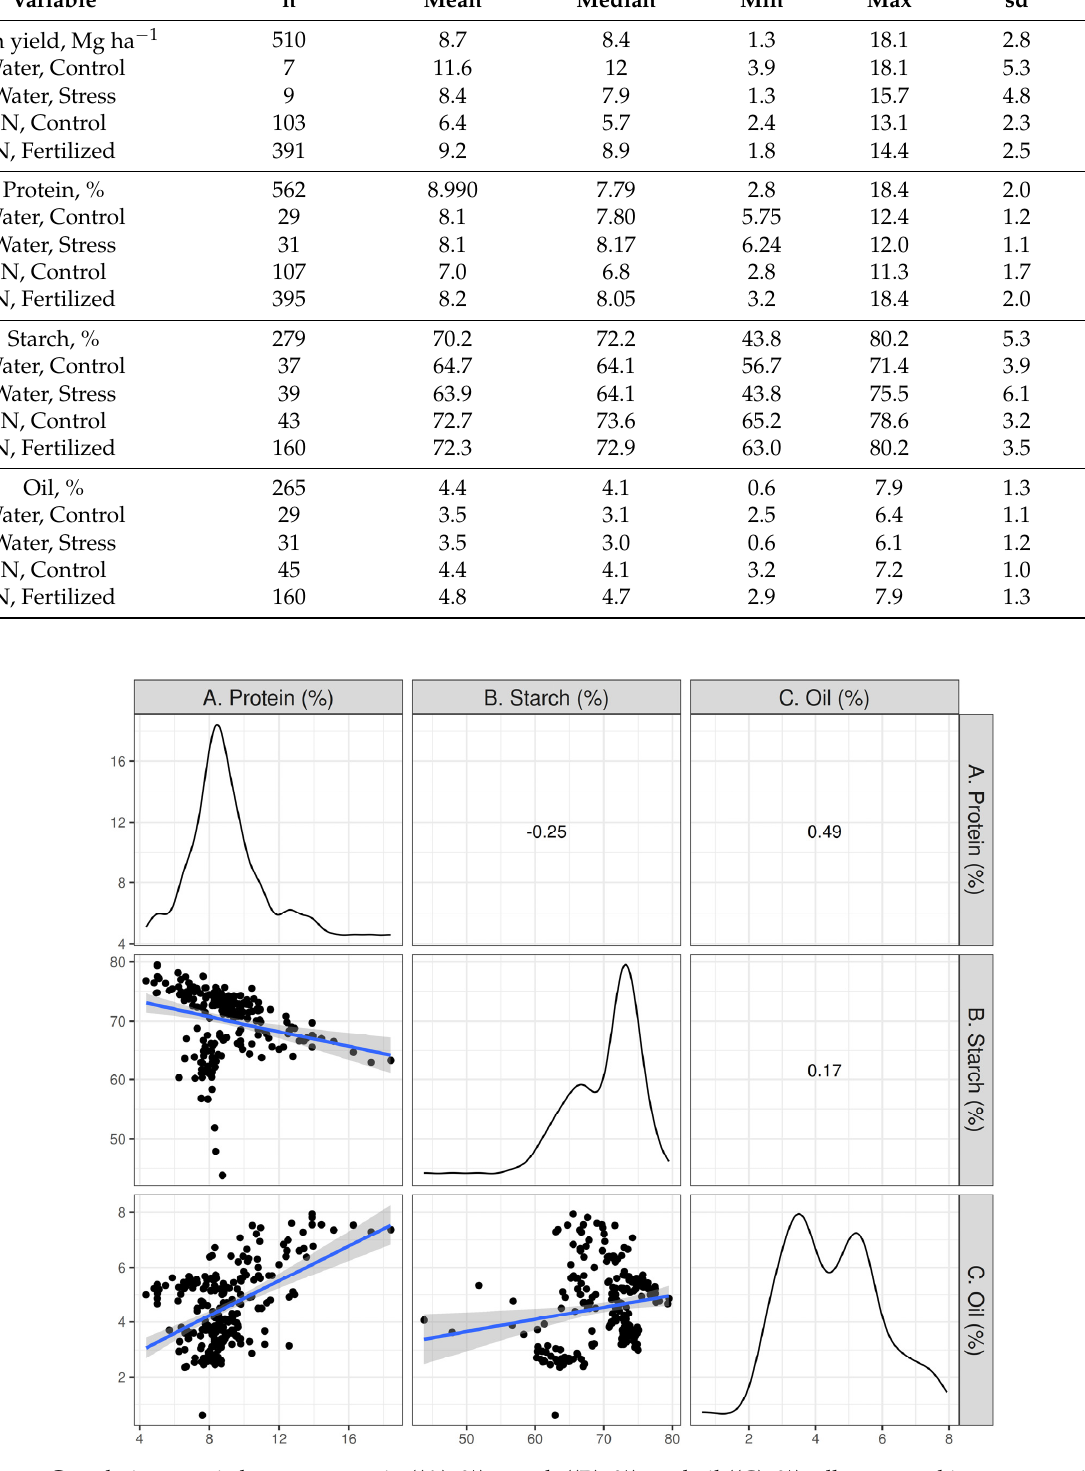
Figure 2. Simple relationships between grain yield (Mg ha –1 , expressed in dry basis) and grain concentration (%) of protein ( A ), starch ( B ), and oil ( C ) (all adjusted to dry basis). For each component, data points belong to multiple studies where both grain yield and the component of interest were quantified.